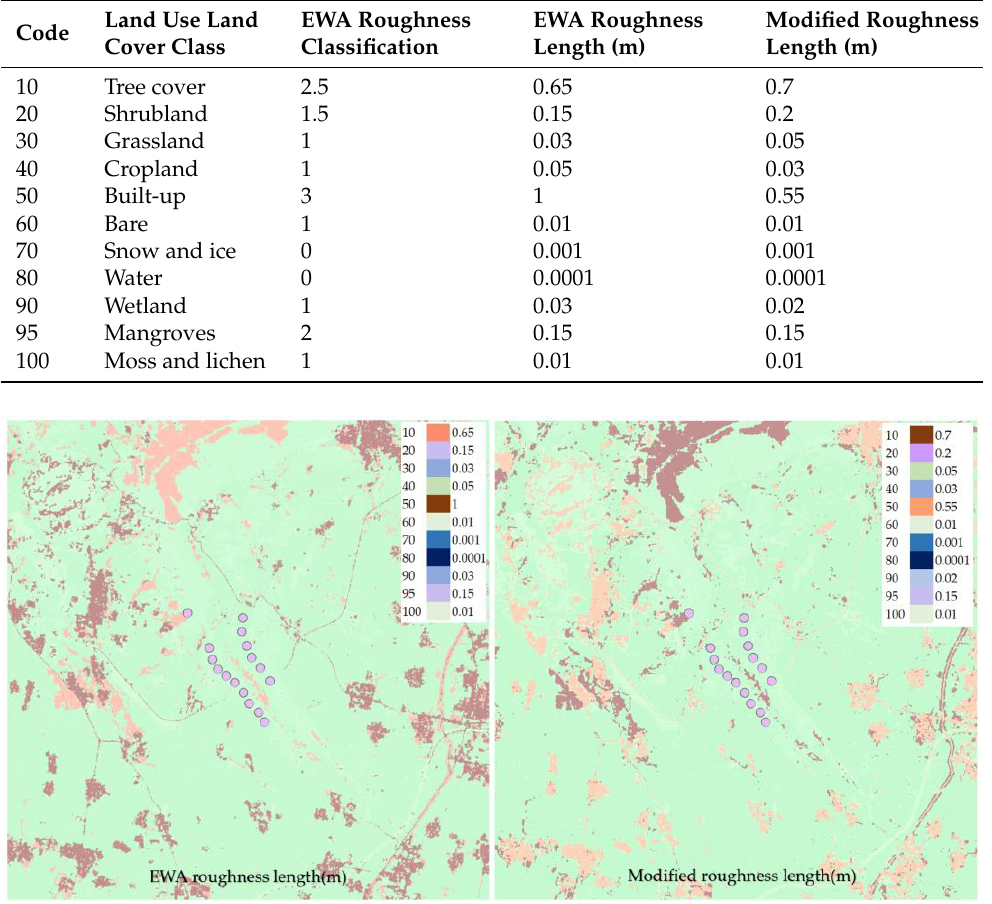
Figure 3. The roughness length map created by land cover data.